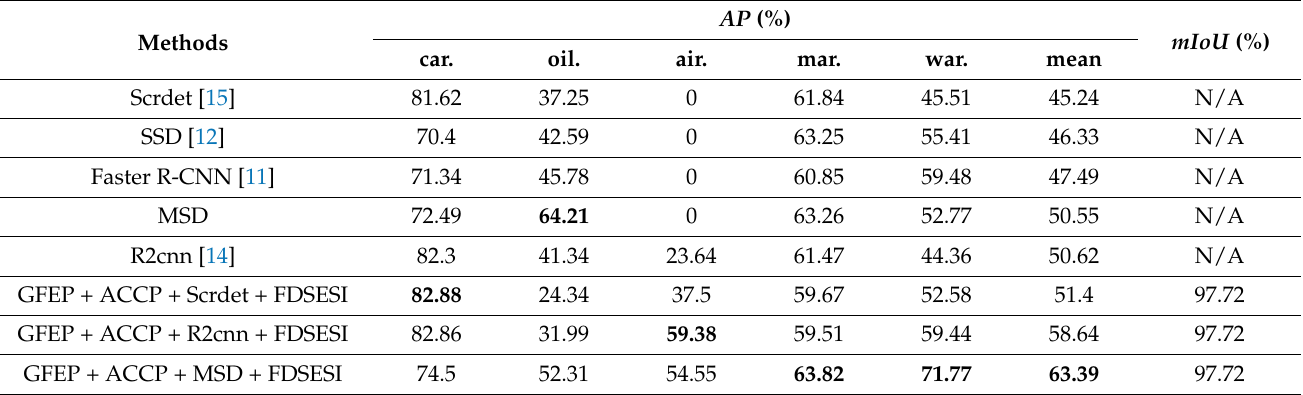
Table 1. Results of AP by class, mAP , and mIoU according to the experimental method.